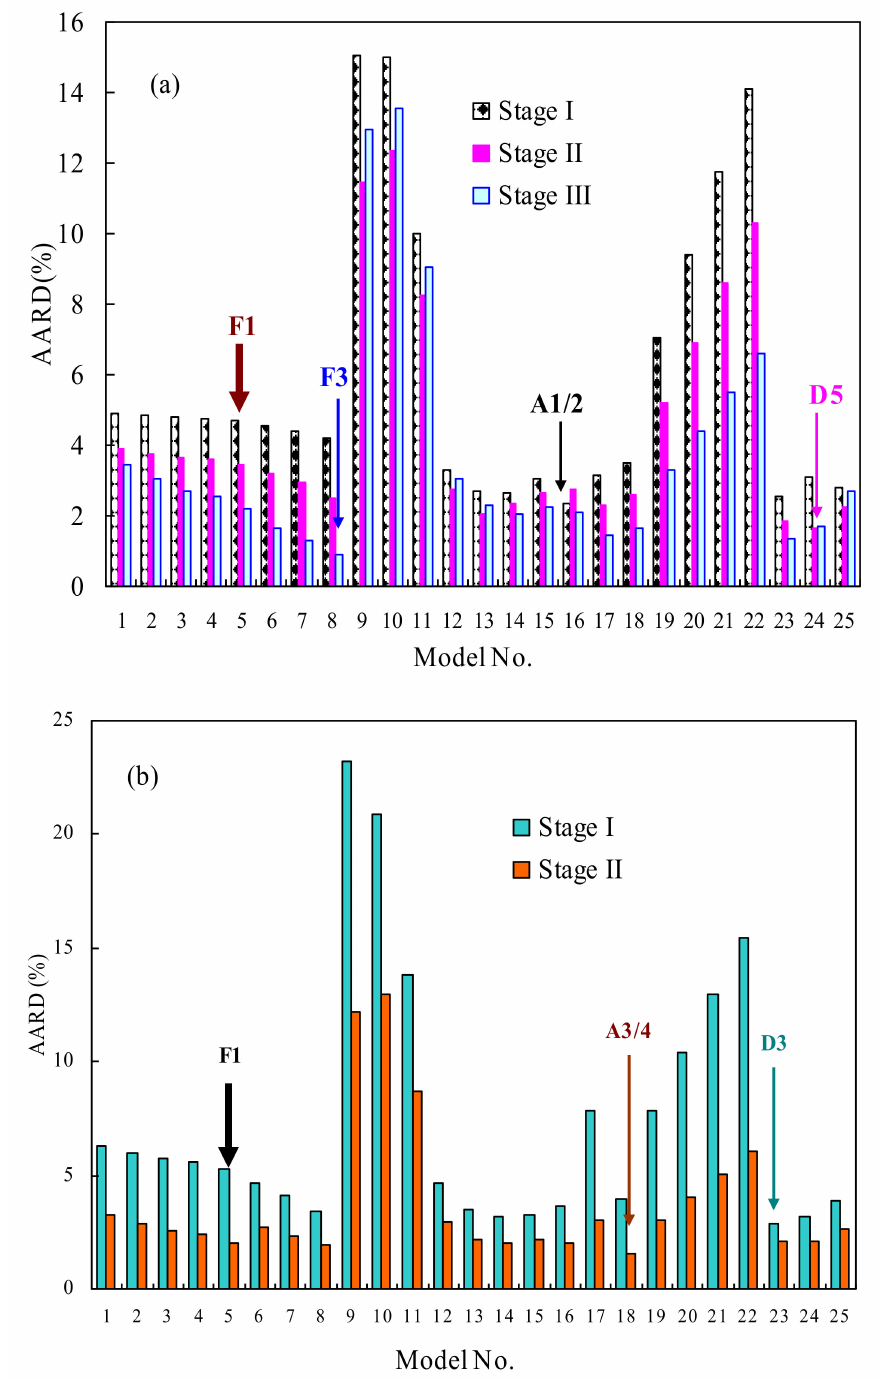
Figure 6. The AARD results for some reaction models along with the CR method for multi-stage pyrolysis processes of TSPU ( a ) and WPU ( b